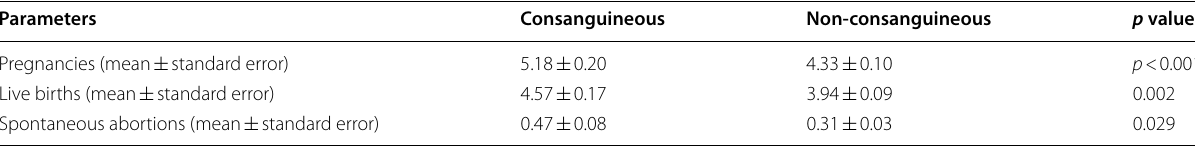
Table 5 The average number of pregnancies, live births, and spontaneous abortions in consanguineous and non-consanguineous unions